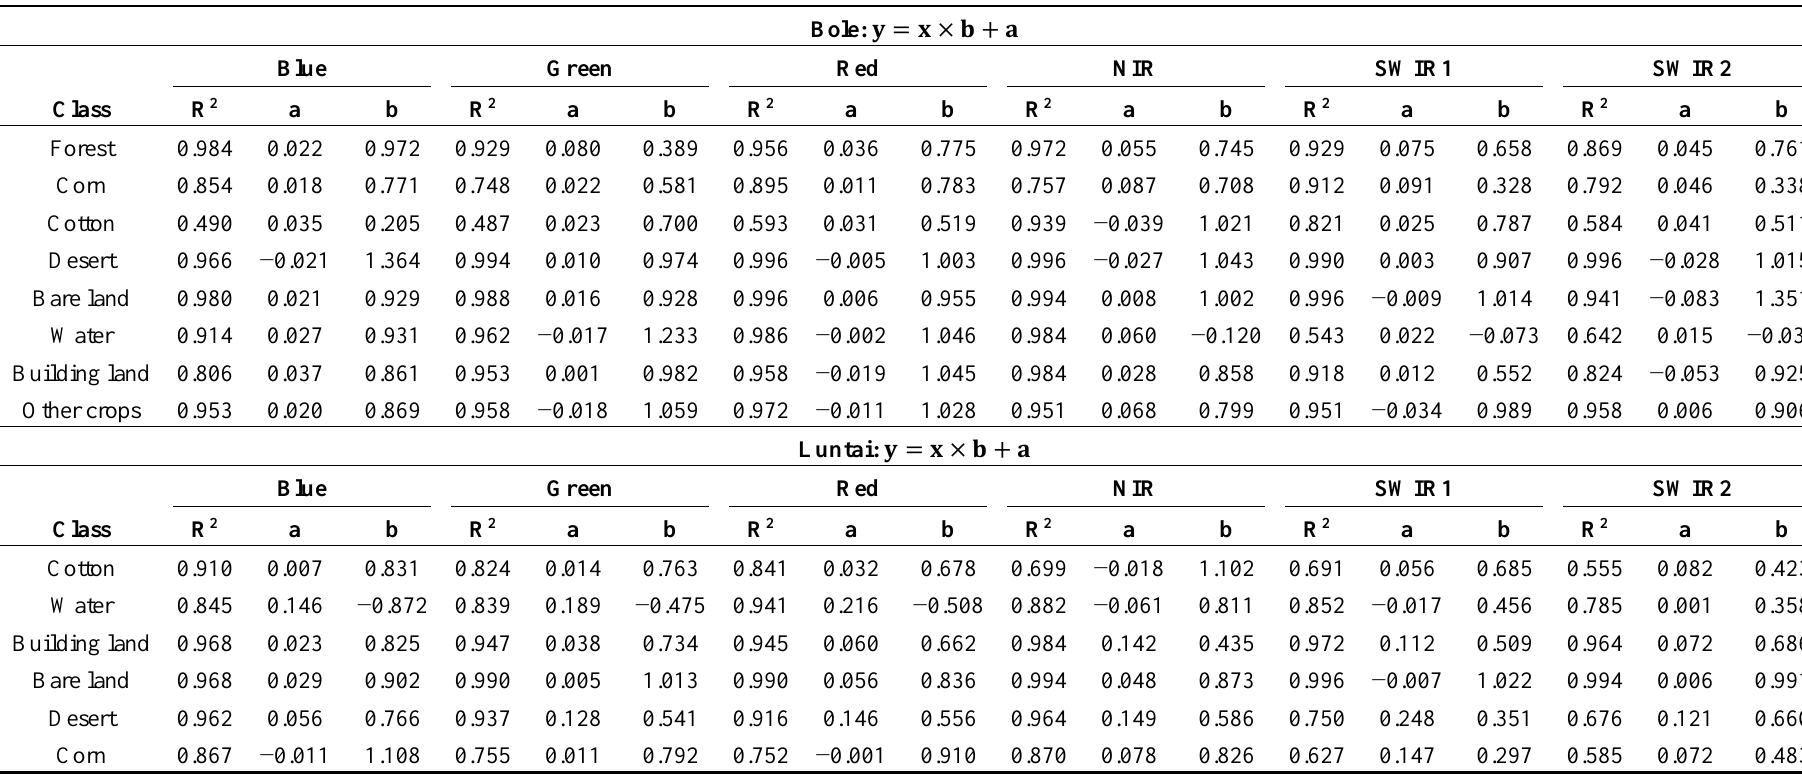
Table 4. Linear model built by linear regression analysis between Landsat mean reflectance and disaggregated mean coarse reflectance. Bole: 𝐲 = 𝐱 × 𝐛 +